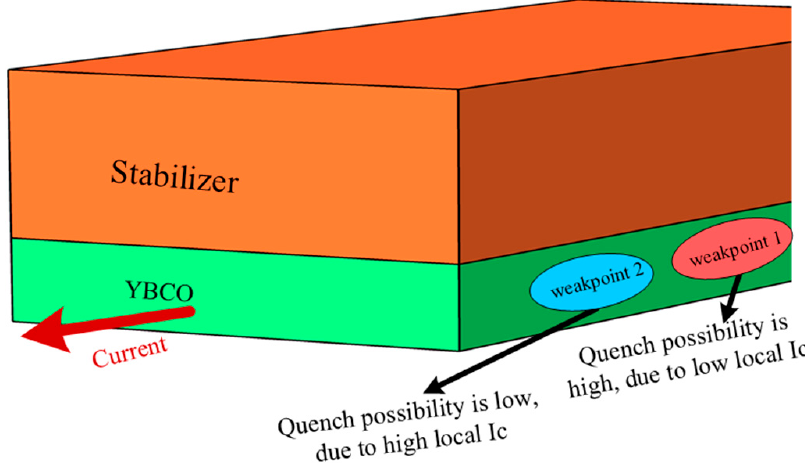
Figure 1. Weak points in YBCO tapes that increase the probability of quenches.